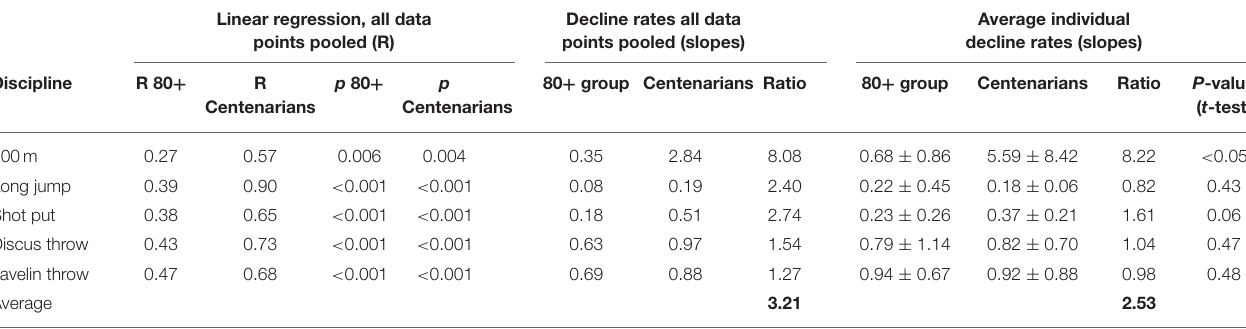
TABLE 2 | Comparison of decline rates between the 80 + -years-old and centenarian group in seconds or meters per year and the ratio. Linear regression, all data points pooled (R)